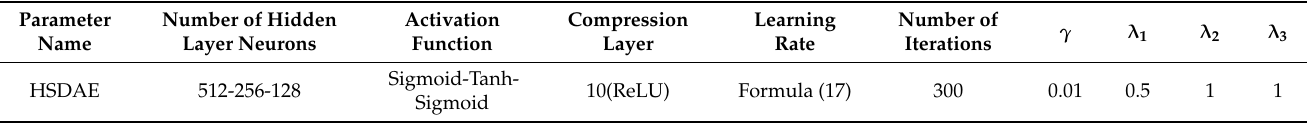
Table 2. The parameter settings of HDSAE in the CWRU data set.